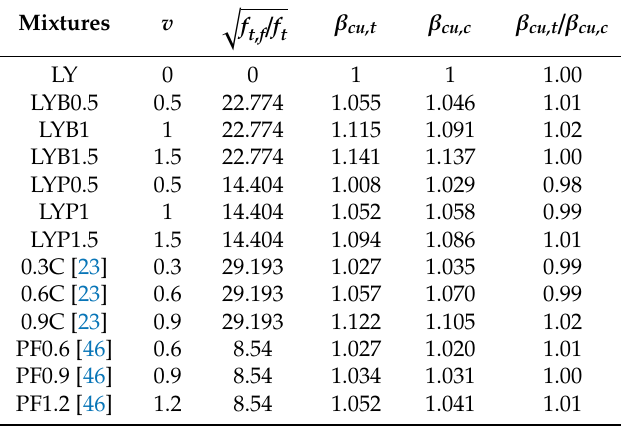
Figure 13. The fitting effect of β cu . Table 5. Comparison of test and calculation results of β cu.